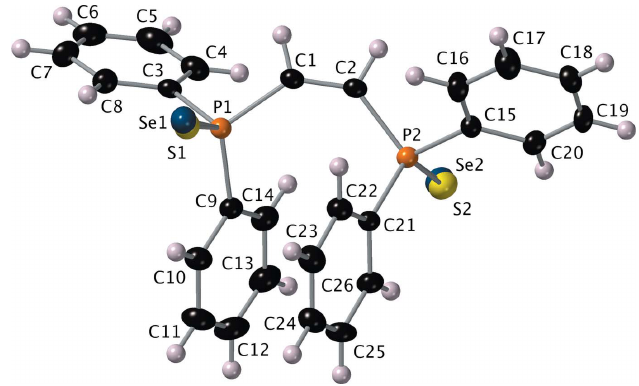
Figure 6 An ellipsoid (50% probability) plot for the final mixed selenide/sulfide model showing the atom-numbering scheme.